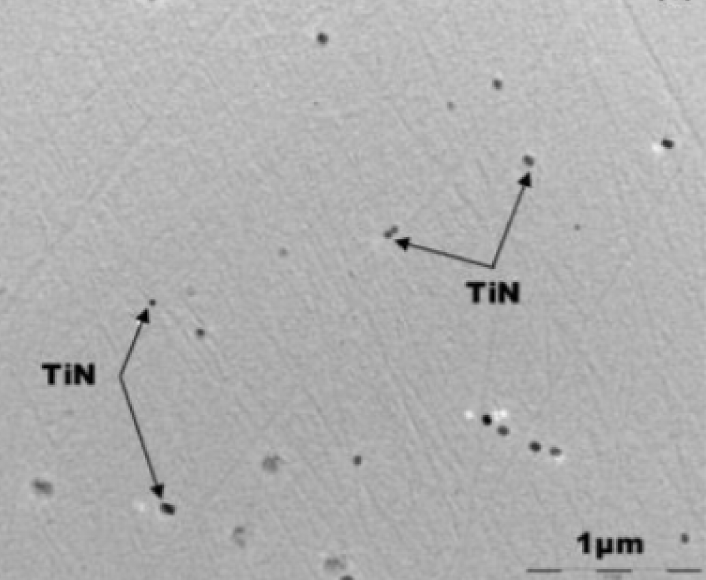
Figure 33. Coarse TiN precipitates in 0.1% Ti, containing B steel, TWIP steel free of Nb, tested at a 1000 ◦ C, Steel 4 in Table 4 [27].